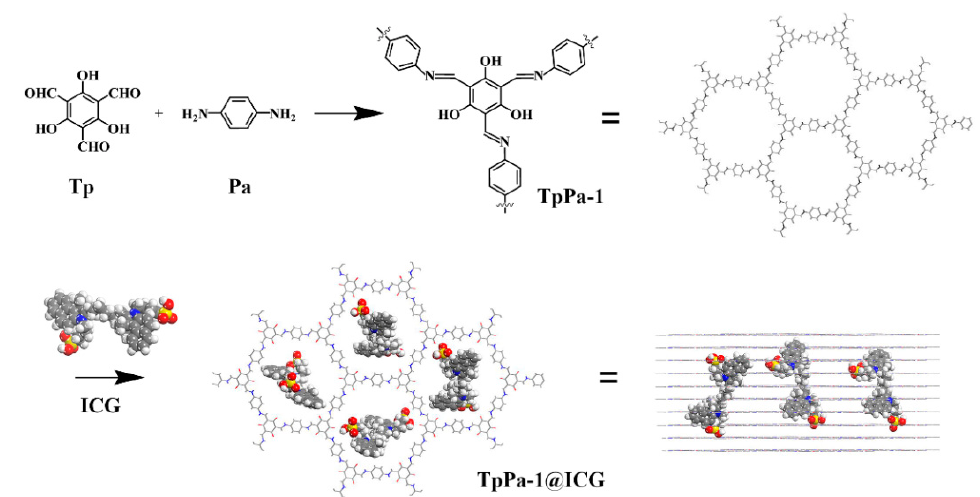
Figure 6. Synthesis of TpPa-1 and TpPa-1@ICG [29–31].